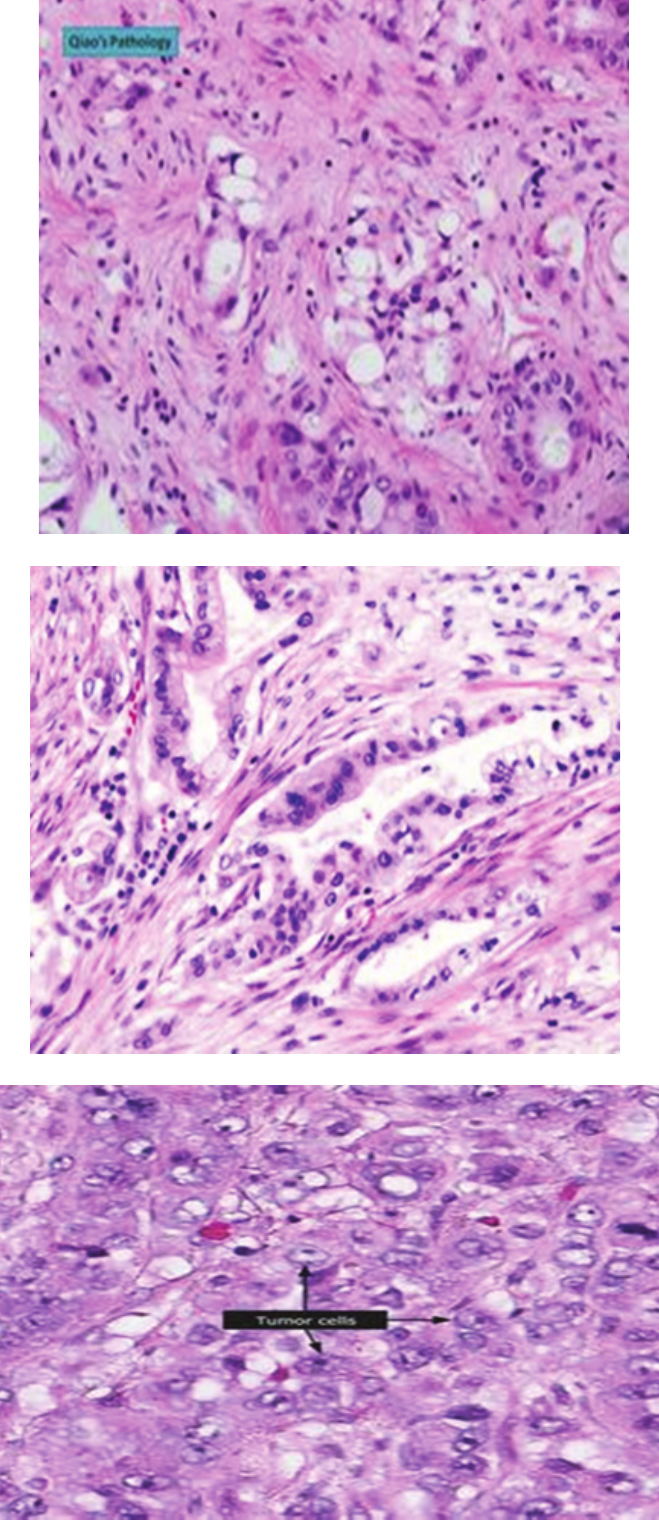
Figure 2 : Periampullary carcinoma H&E stain × 40: (a) well-differentiated; (b) moderately diffrentiated; and (c) poorly